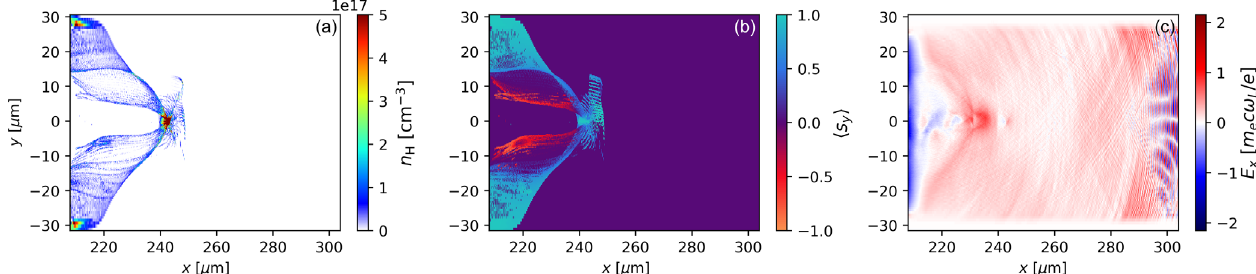
FIG. 2. (a) Proton density distribution after t ¼ 1 . 1 ps for two a 0 ¼ 100 laser pulses propagating through the HCl target. The highest density can be seen in toward the central axis (color bar clipped for better visibility). (b) Average spin in the y -direction of the protons. Due to the prevalent electromagnetic fields, part of the protons (see red region around x ¼ 220 μ m) become depolarized. (c) The accelerating field E x behind the edge of the plasma